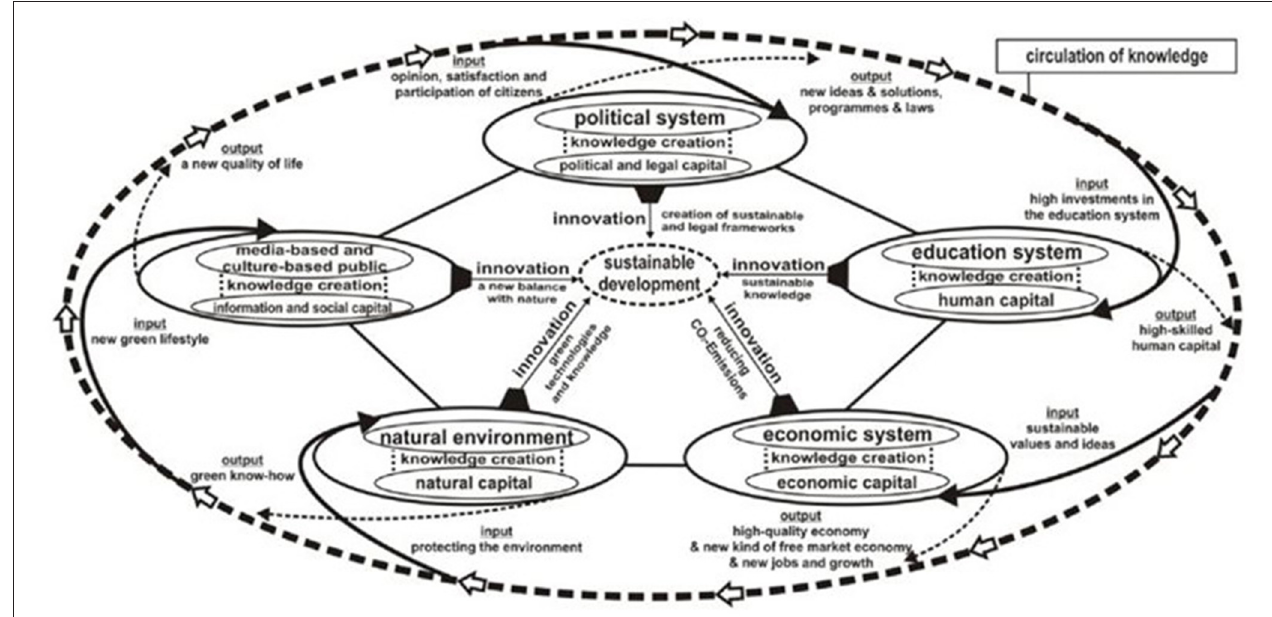
FIGURE 3 | Quintuple helix model and its five